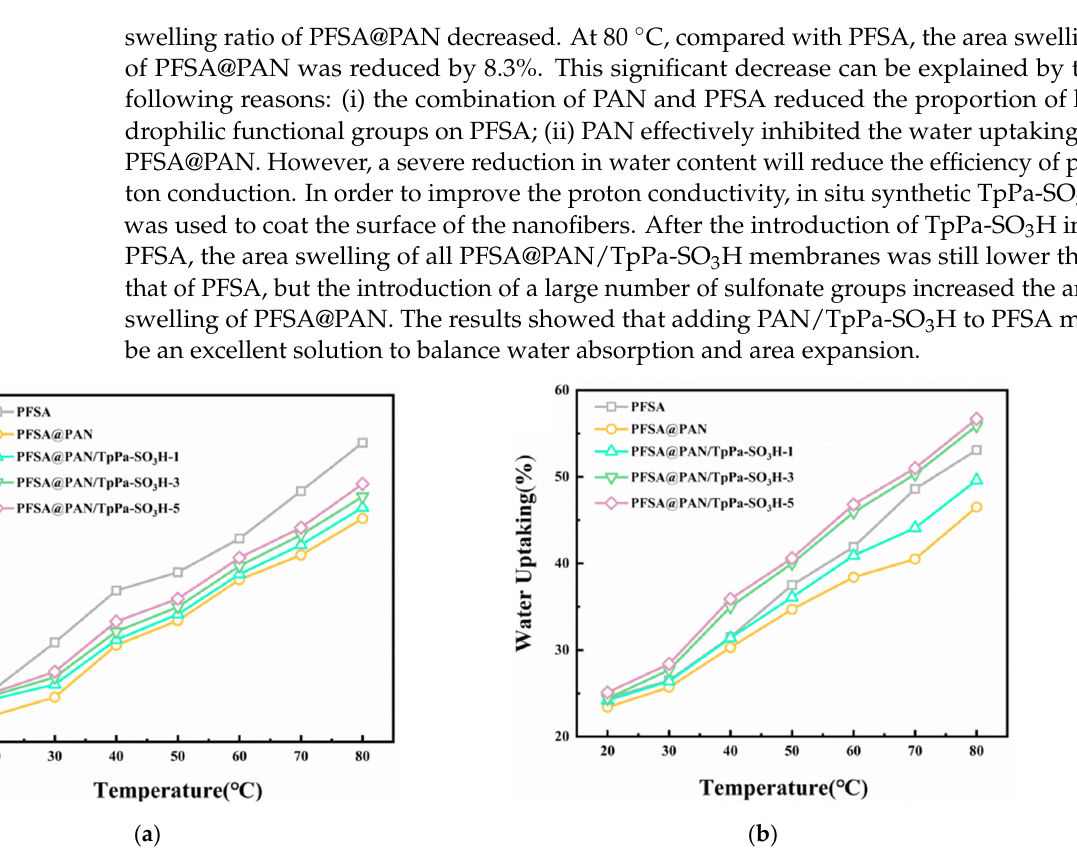
( e ) Figure 5. Cross ‐ sectional SEM images of ( a ) PFSA, ( b ) PFSA@PAN, ( c ) PFSA@PAN/TpPa ‐ SO 3 H ‐ 1, ( d ) PFSA@PAN/TpPa ‐ SO 3 H ‐ 3, and ( e ) PFSA@PAN/TpPa ‐ SO 3 H ‐ 5. 3.3. Water Uptaking and Area Swelling Ratio Water uptaking and area swelling play important roles in characterizing proton con ‐